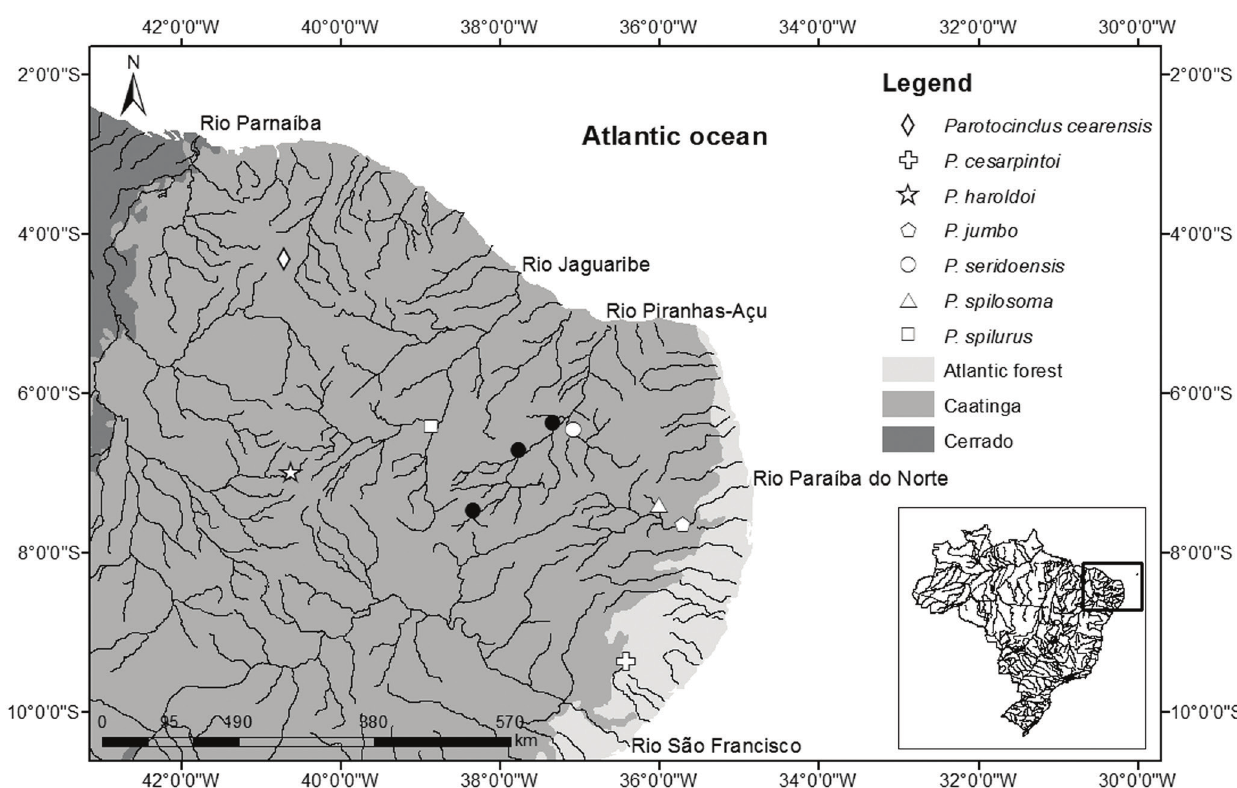
Fig. 5. Geographic distribution of Parotocinclus species in Mid-Northeastern Caatinga region and rio Parnaíba basin, north- eastern Brazil. Open symbols represents type